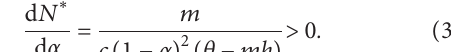
Figure 2: Bifurcation diagram of system (27) for the bifurcation parameter α . (a, b) The change of population biomass for k � 0, and in that case, the system undergoes a supercritical Hopf bifurcation at α [ h ] � 0 . 515 and a transcritical bifurcation at α [ tc ] � 0 . 9332. (c, d) The change of population biomass for k � 0 . 1, in which case the values of α [ h ] drops significantly. Moreover, for higher level of fear, that Hopf bifurcation disappears; that is, no oscillatory behaviour is observed in (e, f). In other words, higher level of fear promotes the coexistence. Blue-coloured curve and red-coloured curve indicate the prey/predator biomass of E respectively. Solid line refers to the stable behaviour, and dashed line refers to the unstable behaviour of the system around any equilibrium point. The dashed-dot curve indicates the max and min of prey/predator population. The set of parameter values taken here is � 2 . 8 , η � 0 . 4 , d � 0 . 9 , 􏼈 a � 0 . 008 , c � 0 . 15 ,h � 0 . 08 , θ � 0 . 3 , m � 0 . 6 } . (a) Change of prey biomass for the bifurcation parameter α and r 1 fixed k � 0. (b) Change of predator biomass for the bifurcation parameter α and fixed k � 0. (c) Change of prey biomass for the bifurcation parameter α and fixed k � 0.1. (d) Change of predator biomass for the bifurcation parameter α and fixed k � 0.1. (e) Change of prey biomass for the bifurcation parameter α and fixed k � 1. (f) Change of predator biomass for the bifurcation parameter α and fixed k �